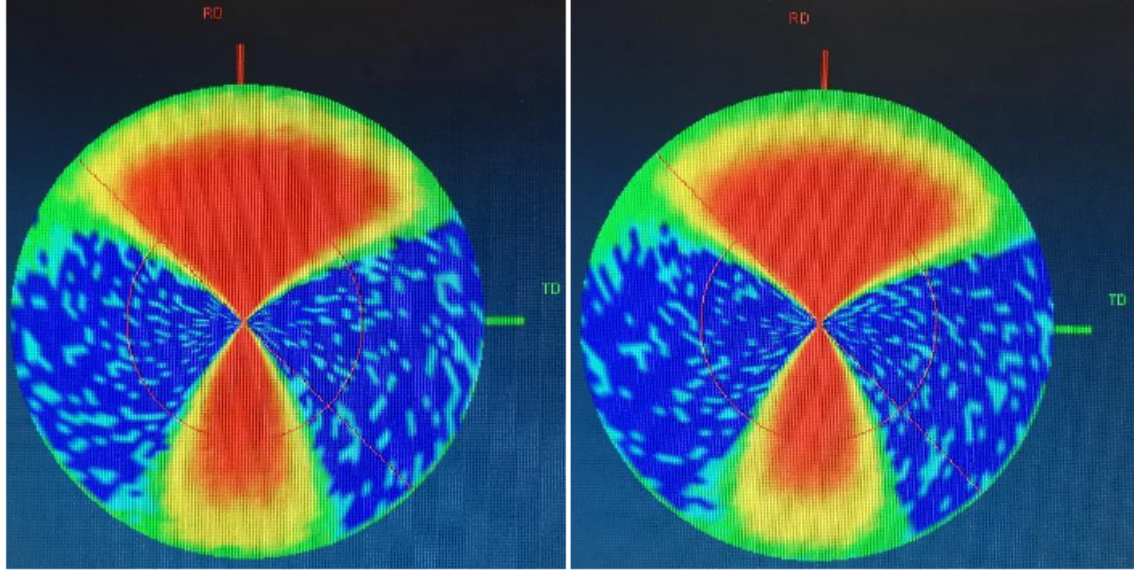
Figure 4: Pole figures recorded on (101) atomic plane. The schematic representation is made in 3D Explore software from Rigaku.